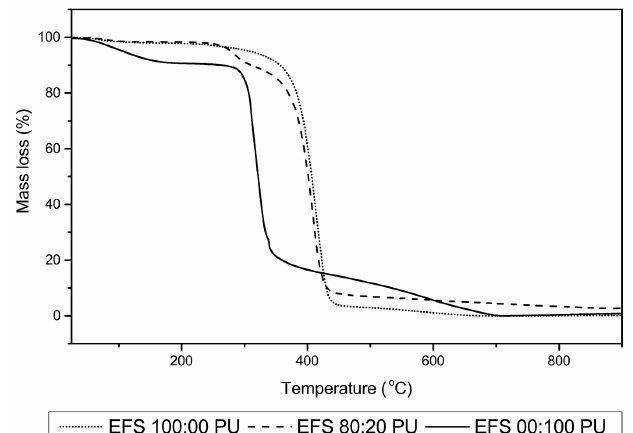
FIGURE 4 - Thermogravimetric analysis of samples of EFS 100:00 PU, EFS 80:20 PU, and EFS 00:100 PU.